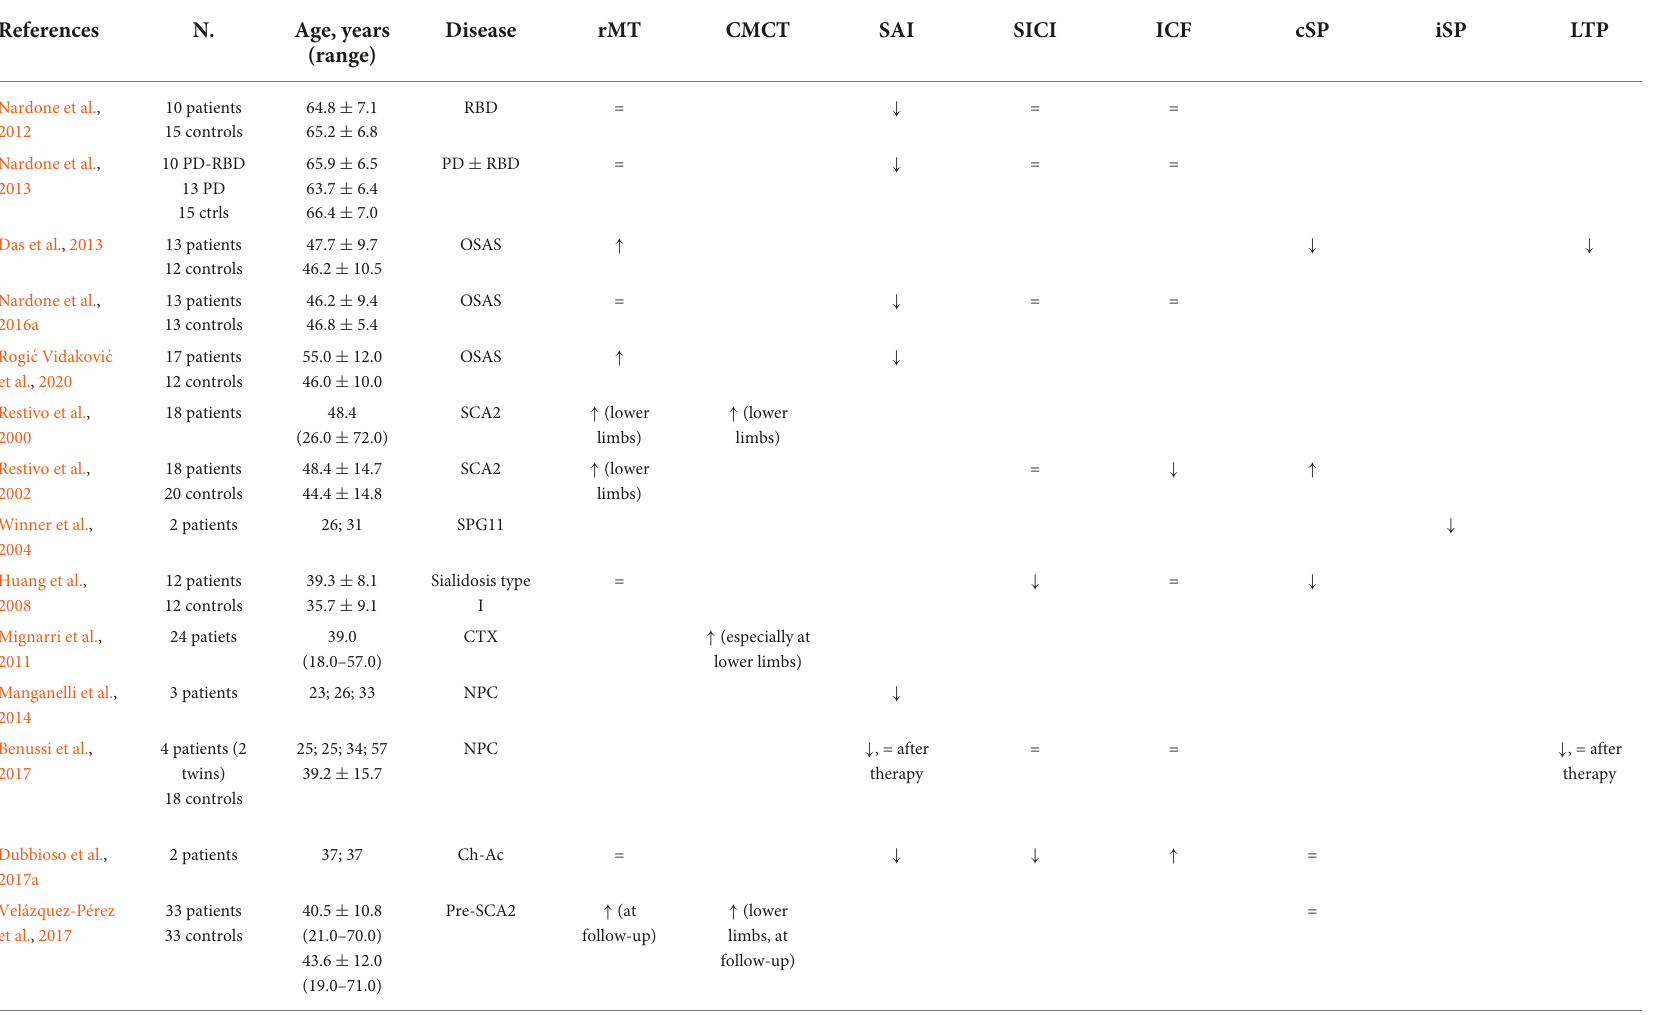
cerebrotendinousxanthomatosis;COVID-19,COronaVIrusdisease-2019;cSP,contralateralcorticalsilentperiod;GFAP,glialfibrillaryacidicproteinastrocytopathy;HE,hepaticencephalopathy,grade1(HE1),grade2(HE2);iSP,ipsilateralsilentperiod; MS, multiple sclerosis; ICF, intracortical facilitation; LICI, long-interval intracortical inhibition; LTP, long-term potentiation; NBIA, neurodegeneration with brain iron accumulation; NPC, Niemann-Pick disease type C; N, number of subjects; NMDA, N -methyl-D-aspartatereceptor;NR,notreported;OSAS,obstructivesleepapneasyndrome;PBC,primarybiliarycirrhosis;PD,Parkinson’sdisease;RBD,REM-sleepbehaviordisorder;rMT,restingmotorthreshold;SAI,short-latencyafferentinhibition;